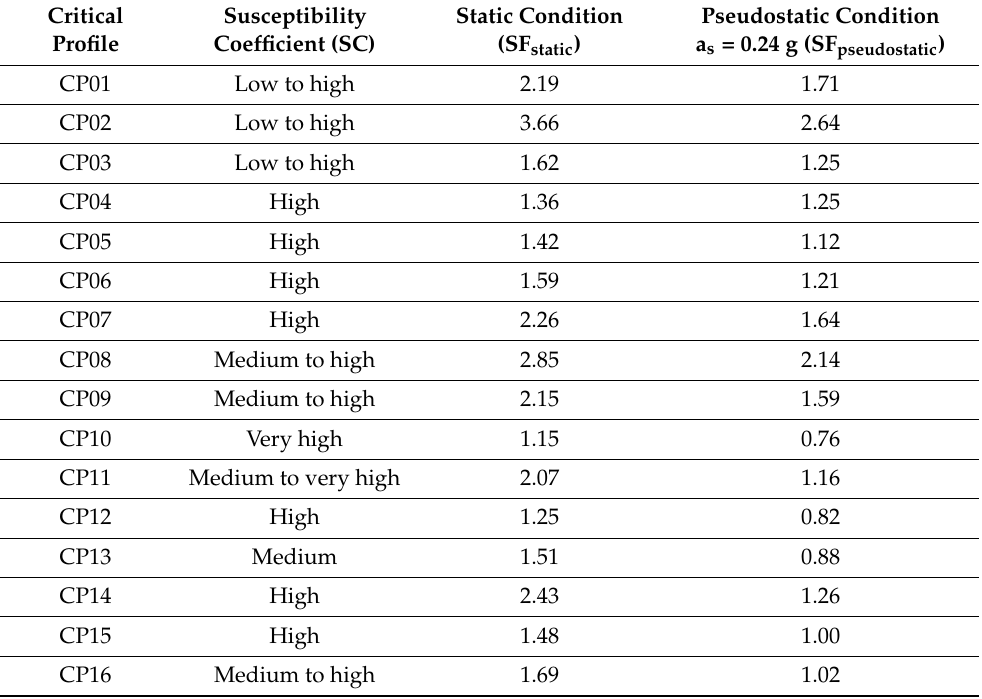
Table 17. Results obtained from the stability analysis considering the 16 critical profiles. Critical